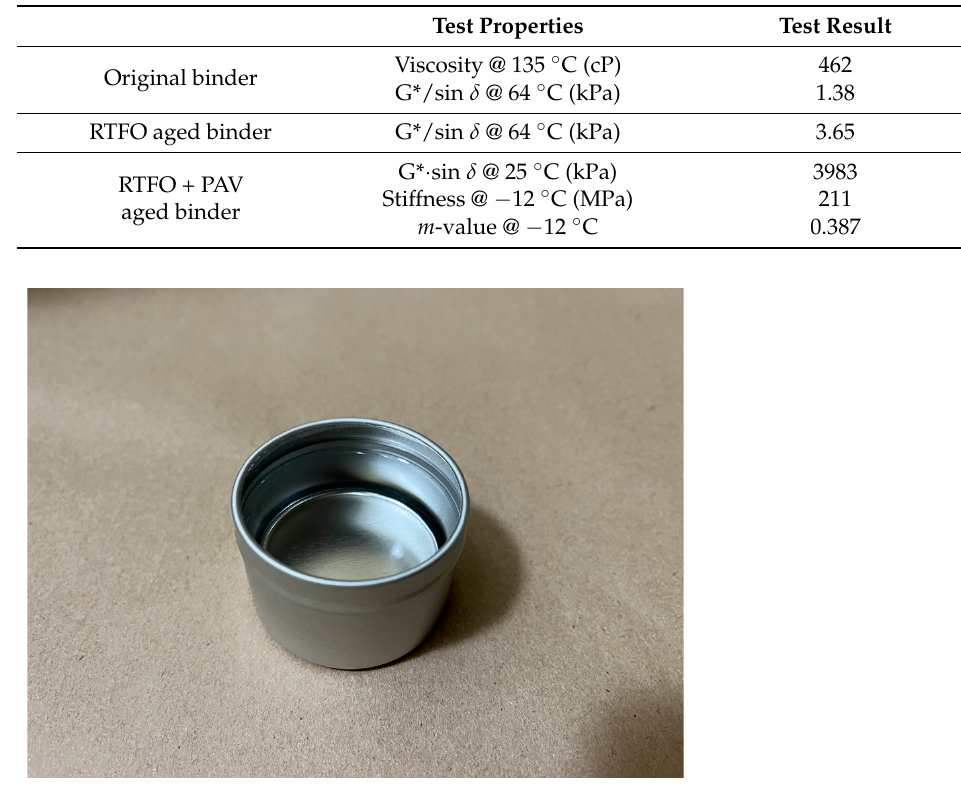
Figure 2. Base oil used in this study. Table 2. Properties of base